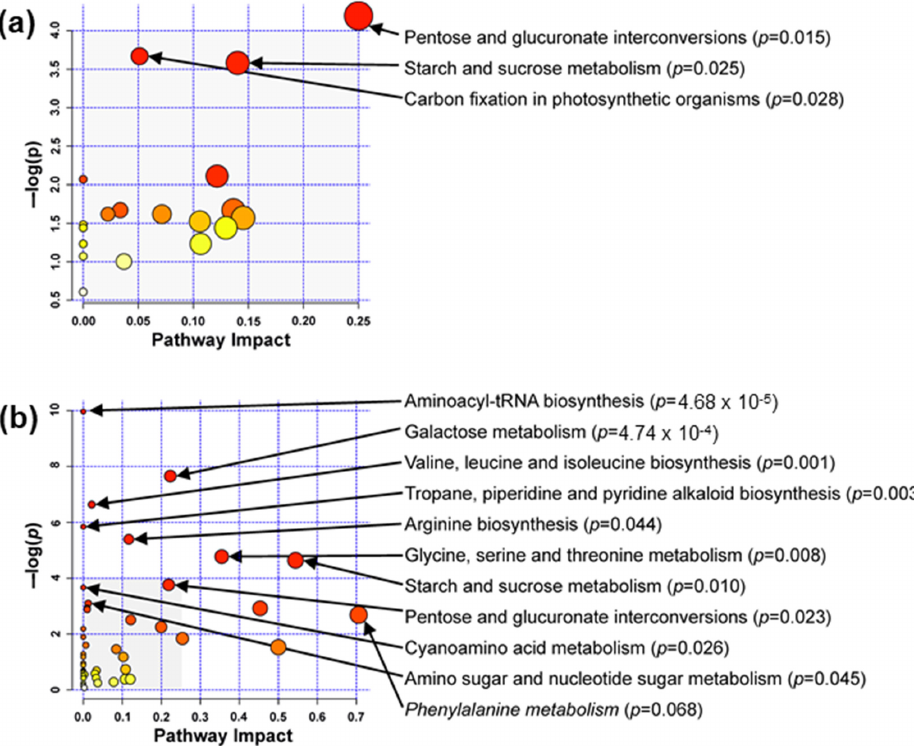
Figure 9. Metabolic pathway enrichment in cotyledons ( a ) and embryonic axes ( b ) performed with the MetaboAnalyst platform and a p < 0.05 threshold. Metabolic pathways are indicated with circles according to their scores from enrichment (vertical axis; ( − log(p)) and topology analyses. Darker colors indicate more significant changes in metabolites in the corresponding pathway. The size of a circle corresponds to the pathway impact score and is correlated with the centrality of the involved metabolites. Because of the highest pathway impact, the ‘phenylalanine metabolism’ pathway is exceptionally visualized ( p = 0.07). The shaded part of chart b corresponds to the whole of chart